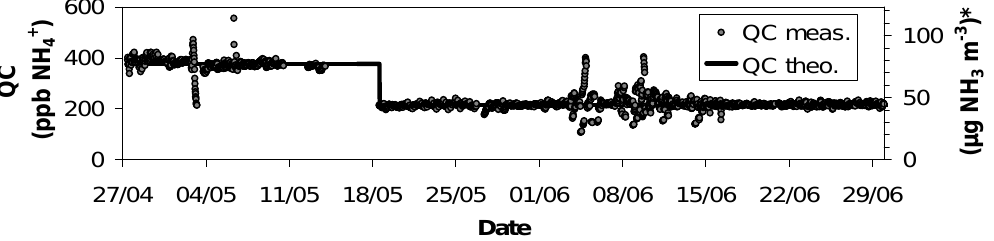
Fig. 5. Measured an theoretical quality control (QC) NH 4+ concentration solution throughout the experiment. On average the difference is 1.3 ppb NH 4+ , with a standard deviation of 22 ppb. The relative difference averages 0.6% with a standard deviation of 8.9%. On the right axis the equivalent atmospheric NH 3 concentration is given using the median liquid sampling volume (5.9 ml) and the median air flow rate (1.2 l min -1 ).